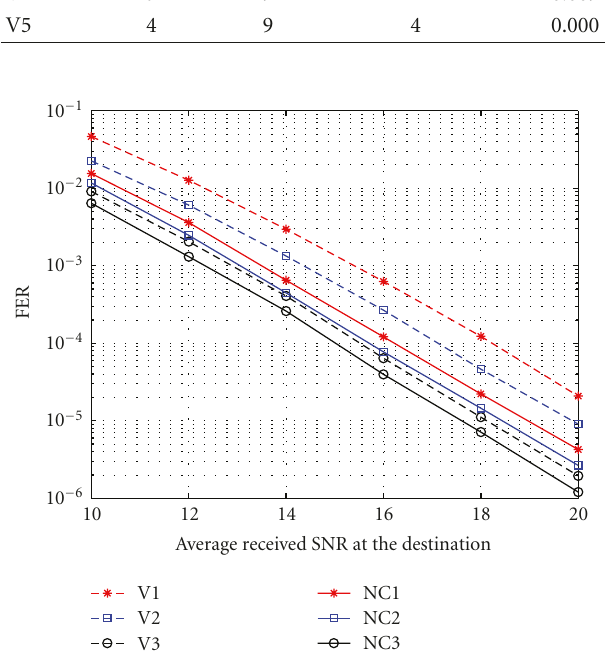
Figure 7: FER performances of 8PSK codes for cooperation